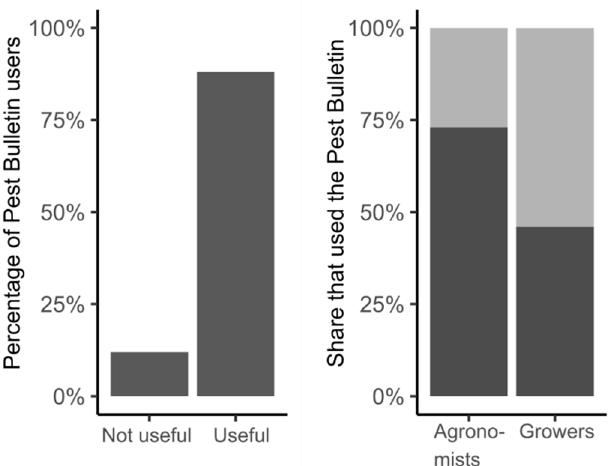
Figure 3. Summary of the results of a questionnaire survey conducted by the Agriculture and Horticulture Development Board (AHDB) to establish the broad range of uses of pest monitoring and forecasting information disseminated to vegetable growers in Britain through the AHDB Pest Bulletin [100].